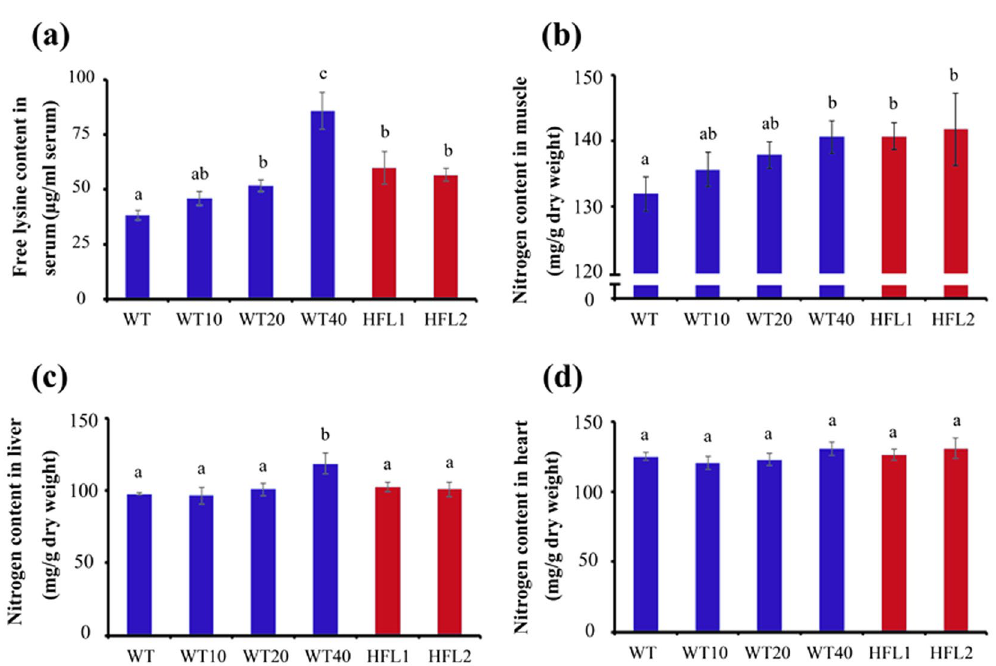
Figure 6. The free lysine content in serum ( a ), nitrogen content in spine muscle ( b ), liver ( c ), and heart ( d ) of rats fed different diets. Error bars represent SD (n = 8). Different letters represent significant differences ( P <